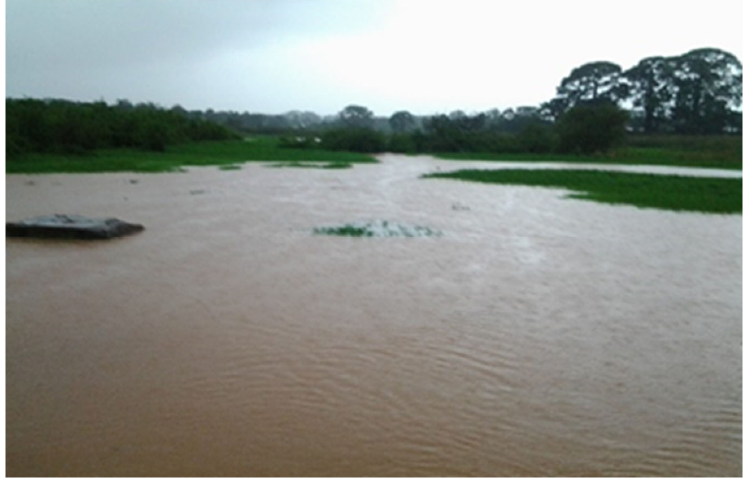
Figure 8. Rice growing areas were flooded by heavy rains on the outskirts of Bissau. Source: SNPC, 2020. SNPC,